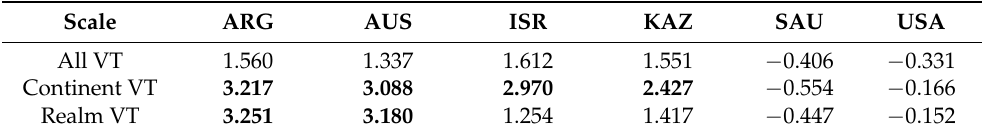
Table 4. Results of randomization tests. Values in the table are Z values, where Z > 1.96 (bold) indicates significant positive deviation in the community aridity index compared with a random null model. The random null model consisted of sampling VT present globally, or present in the continent or biogeographic realm corresponding to the sample location. Scale ARG AUS ISR KAZ SAU USA All VT 1.560